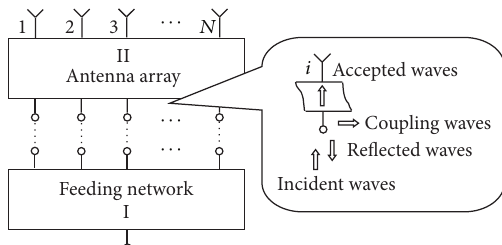
Figure 2: Interconnection between the feeding network and antenna